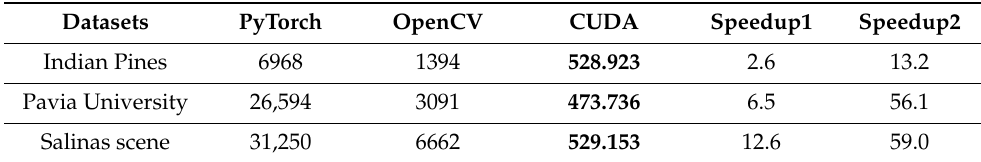
Table 7. Run time (ms) of INAPC of di ff erent versions for the three datasets.